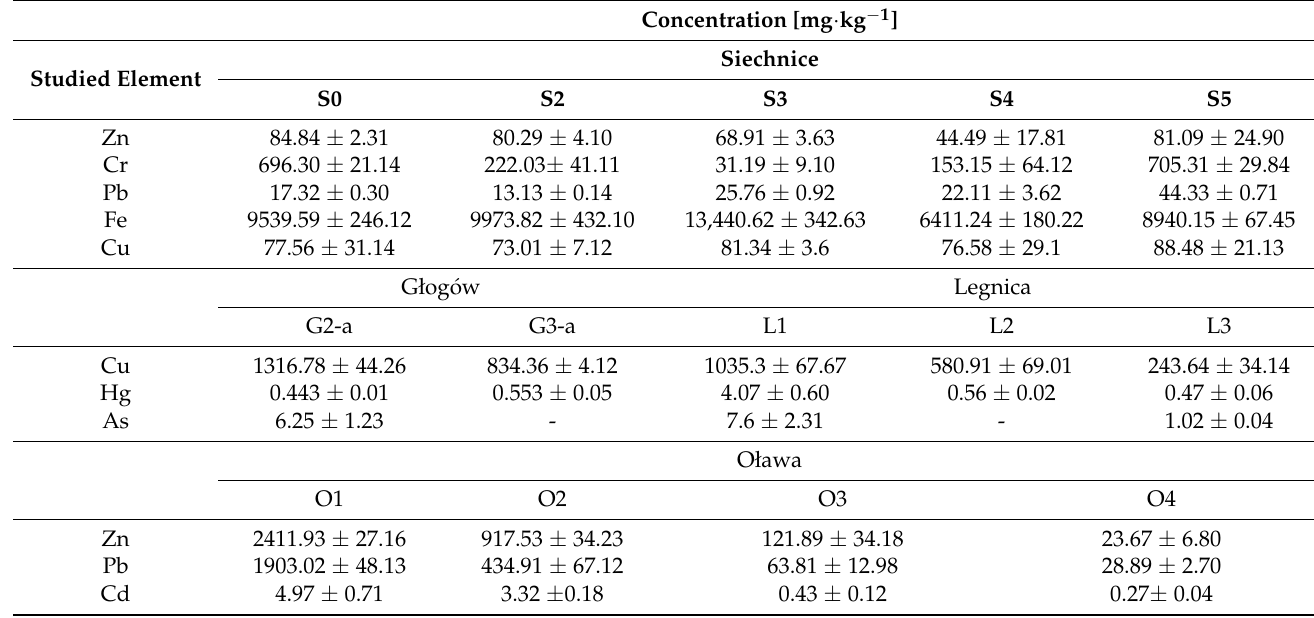
Table 1. The concentrations of heavy metals [mg · kg − 1 ] in the vicinity of four studied smelters.